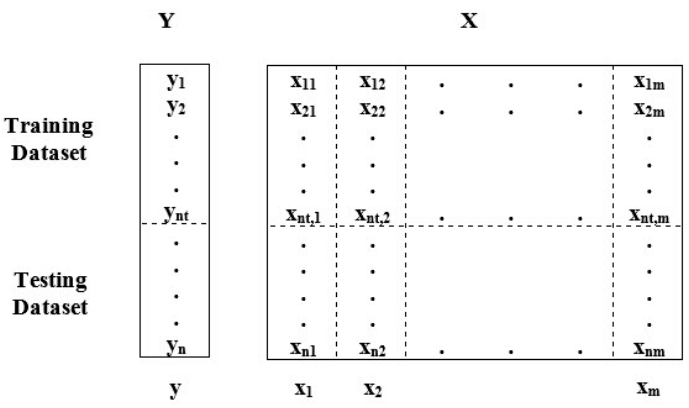
Figure 3. Schematic structure of the GMDH algorithm [46].